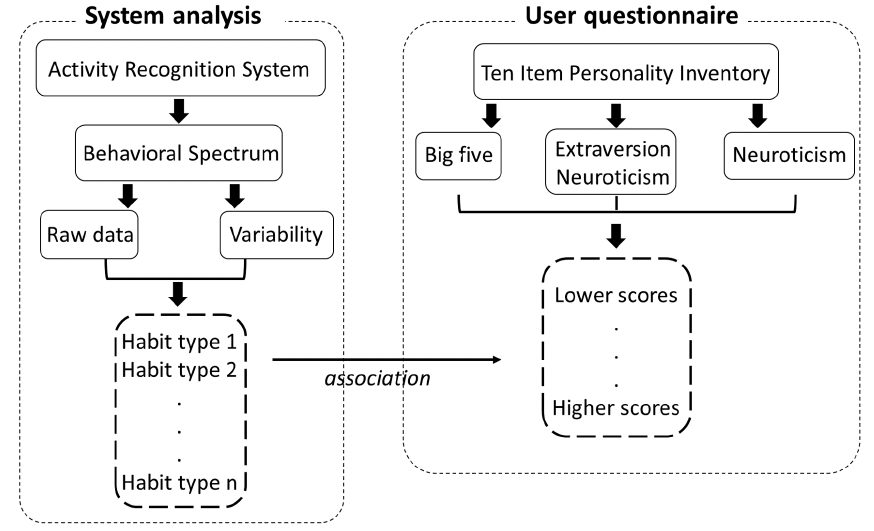
Figure 4. Methodology to find the correlation between habits and personality